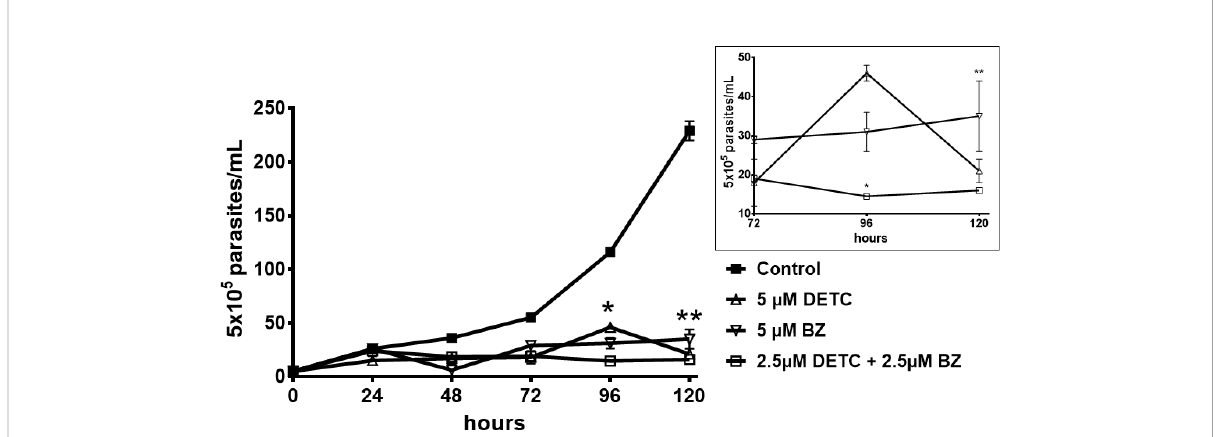
FIGURE 3 Evaluation of the in vitro proliferation of T. cruzi epimastigote forms (Y strain), challenged with DETC and BZ combined or alone. 10 5 parasites were incubated for 5 days with 5 µM DETC, 5 µM BZ and the combination of 2.5 µM each compound. The effects of the compounds were evaluated by daily quantitation of parasites by light microscopy. Inset displays 72-120 h data in a different scale. The combined drugs effectivity was signi fi cant, (* p < 0.05; ** p < 0.01), despite the reduced concentrations, as compared to the parasites treated with BZ by the 2-way ANOVA. Data represent the mean ± SD (n =